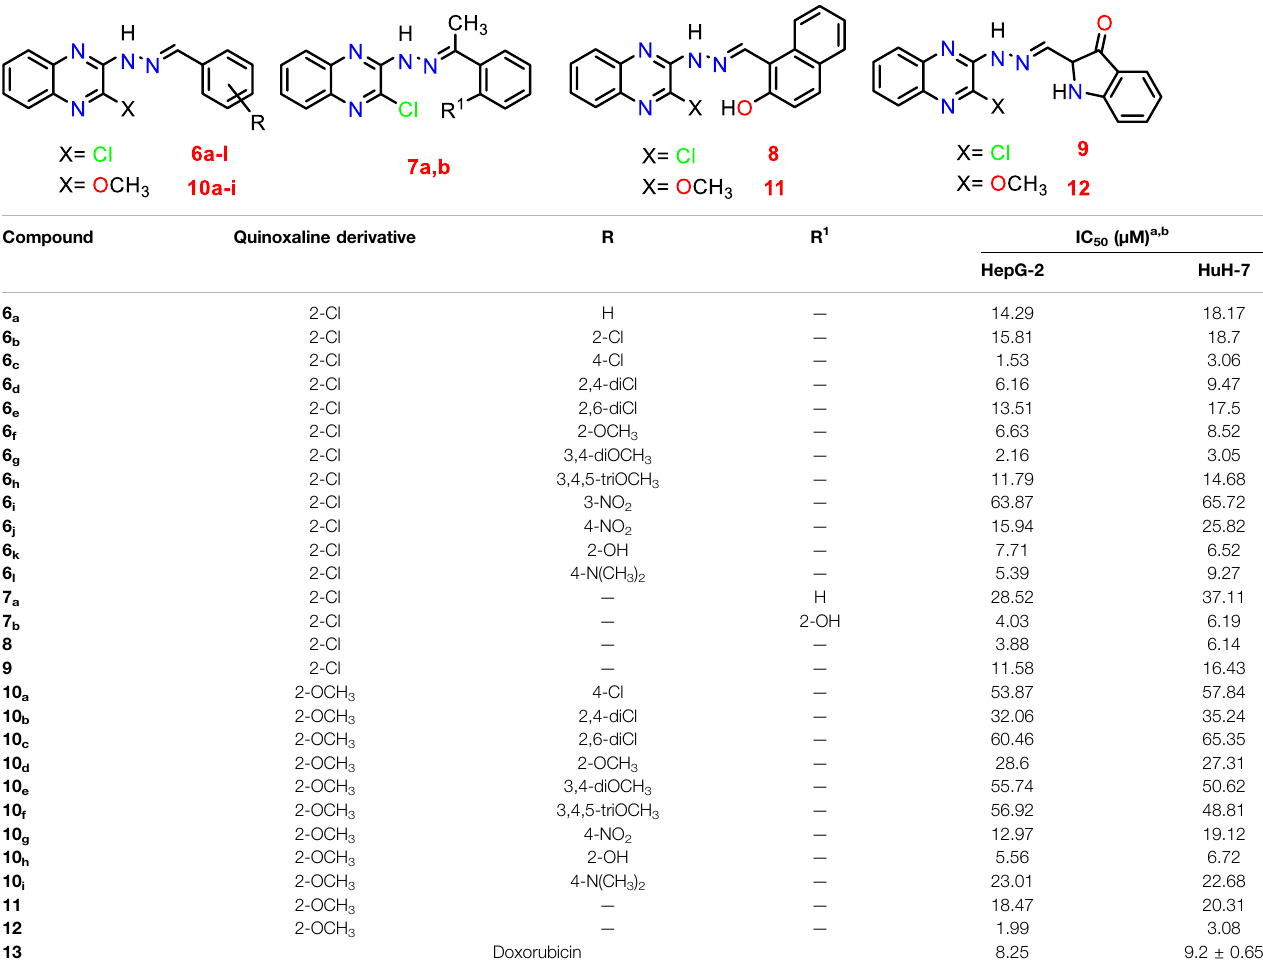
TABLE 1 | Anti-proliferative activities for 6 a-l , 7 a,b , 8 , 9 , 10 a-i , 11 , and 12 compounds against HepG-2 and HuH-7 liver cancer cell lines.